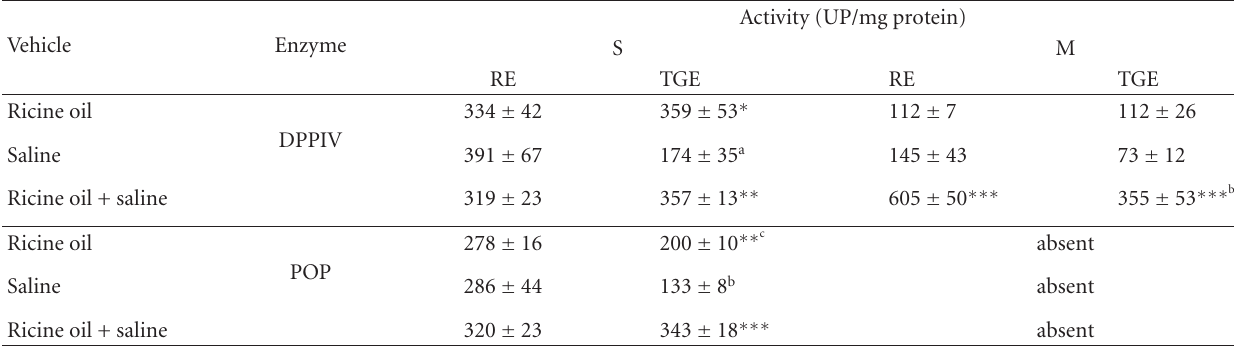
Table 1: Dipeptidyl peptidase IV (DPPIV) and prolyl oligopeptidase (POP) activities in soluble (S) and membrane-bound (M) fractions of resident (RE) and thioglycollate-elicited (TGE) macrophages from vehicle-treated animals (ricine oil s.c. = controls of cyclosporine;